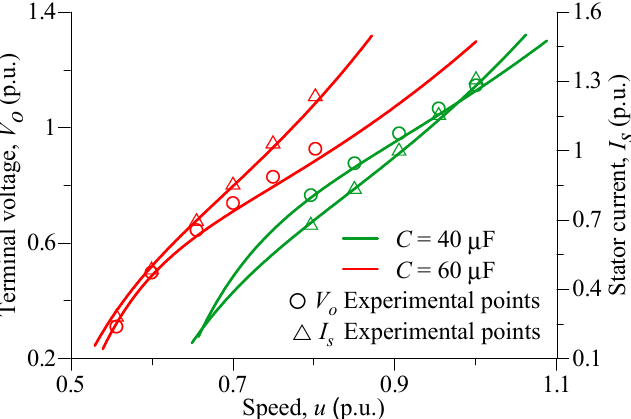
Figure 14. Variation of terminal voltage V o , stator current I s , and frequency F versus speed under no load.